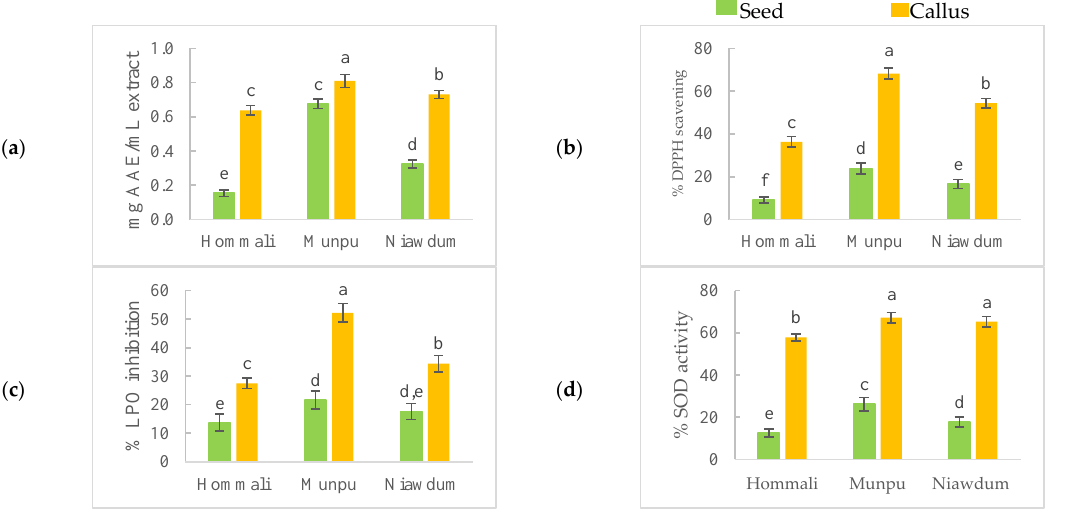
Figure 3. Anti-oxidant activities of rice callus and seed extracts including PFRAP ( a ), DPPH scavenging ( b ), LPO ( c ), and SOD ( d ). Values are presented as means ± SD ( n = 3). Data with different letters (a, b, c, d, and e) indicate significant differences ( p < 0.05) between samples. DPPH scavenging indicates the hydrogen-donating ability of the extract. When a so- lution of DPPH • radical is mixed with that of an antioxidant compound (AH), which can donate a hydrogen atom (H • ) to DPPH • , then this free radical transforms to the reduced form (DPPHH) losing its violet color [49]. In Figure 3b , Munpu callus extract showed 68.22% DPPH scavenging activity which was significantly higher than that of Niawdum and Hommali calli (54.40% and 36.30%, respectively). Furthermore, it was found that the DPPH levels significantly increased in the callus cultures when compared to their seed extracts. The optimum concentration range of ascorbic acid to plot the standard graph of % inhibition of the DPPH conditions was determined and the standard curve was Y = 317.63X − 0.9685 (R 2 = 0.9989). All of the extracts displayed lower DPPH scavenging than